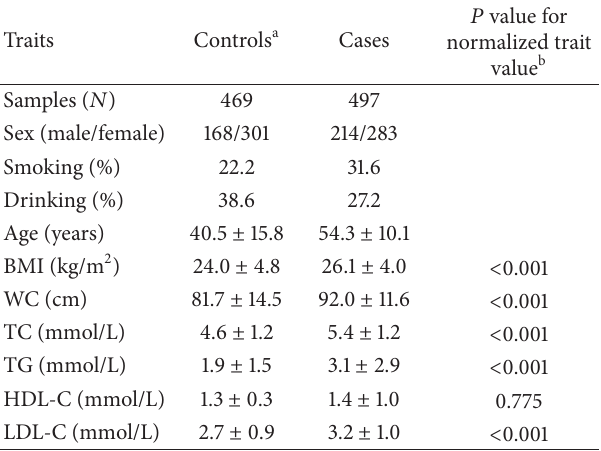
Table 1: Clinical characteristics of study population.